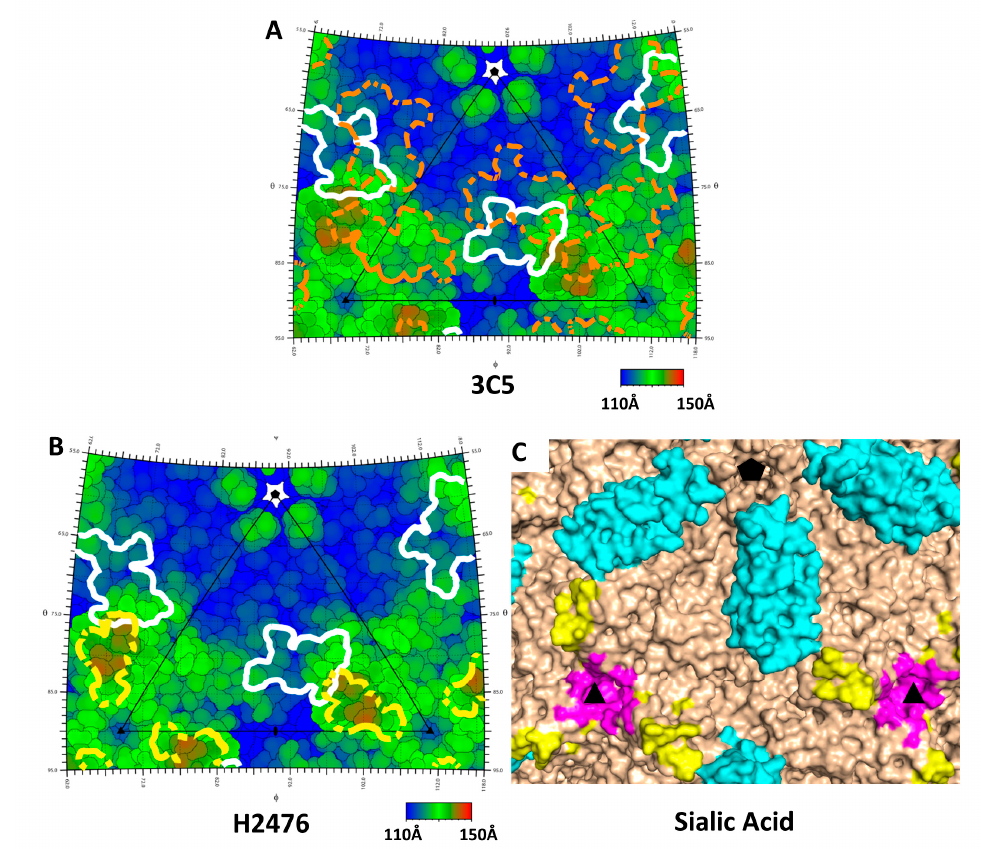
Figure 5. Roadmaps show footprints of PKD1 (white) with 3C5 ( A ) and H2476 ( B ) on AAV5 rendered with the same perspective as Figure 3. ( C ) A 3D surface representation of AAV5 shows the H2476 footprint (yellow) in approximately the same proximity to residues implicated in sialic acid binding attachment (magenta) and the PKD1 domain of AAVR (cyan) implicated in cell entry.